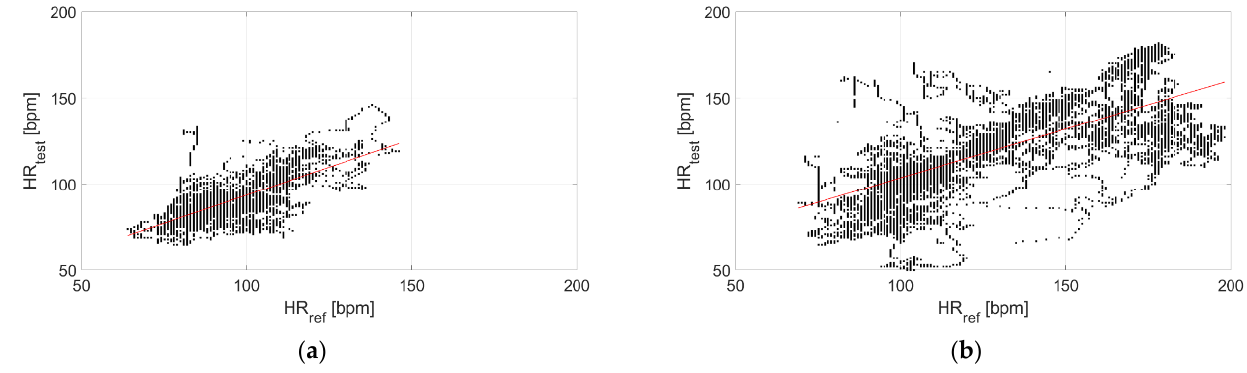
Figure 15. Correlation of measurements performed through Garmin Venu Sq with respect to reference sensor (Polar H10) related to recordings made ( a ) In resting and ( b ) During activities, including recordings both at in-water and dry conditions (reference instrument: Polar H10).